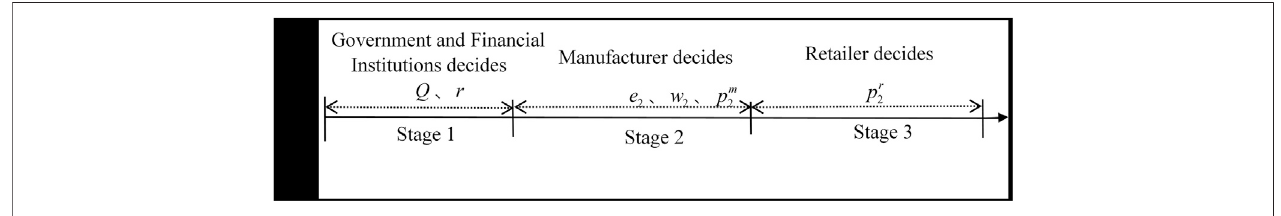
FIGURE 3 | The second decision sequence